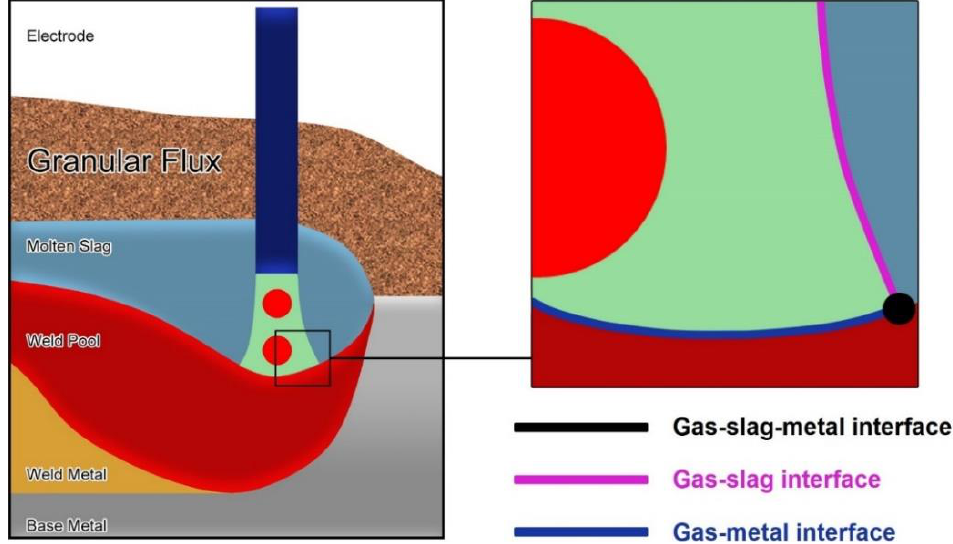
Figure 2. Schematic diagram of SAW and gas-associated reaction interface.